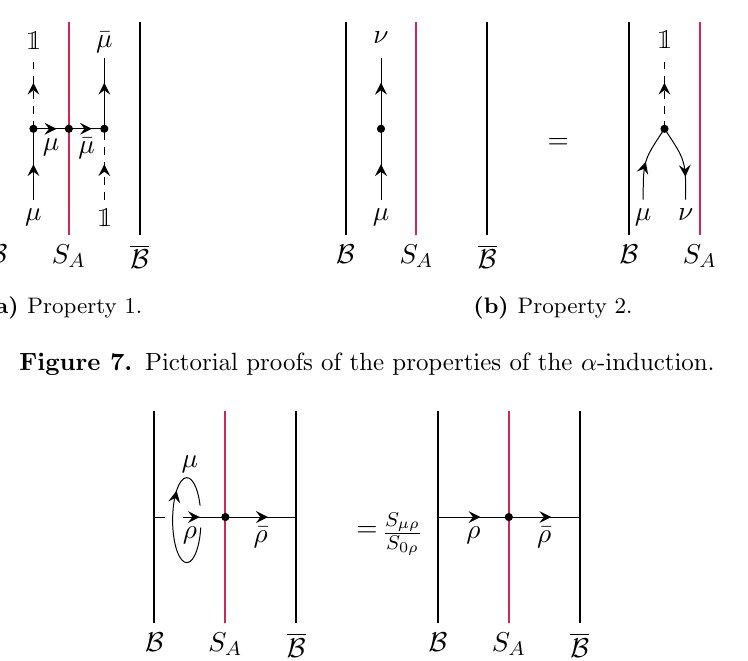
on a local operator in the ( (cid:26); (cid:22) (cid:26) ) (cid:22)